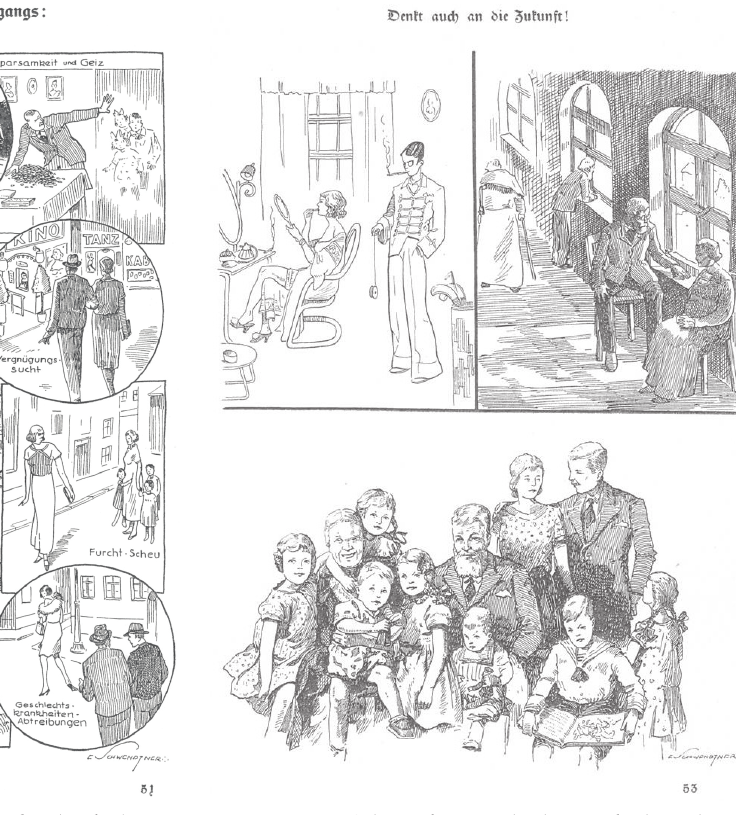
Figure 16. E. Schwendtner, ‘Who has made the right decision? Also think about the future!’ in: Otto Helmut, Volk in Gefahr (München: Lehmanns Verlag,